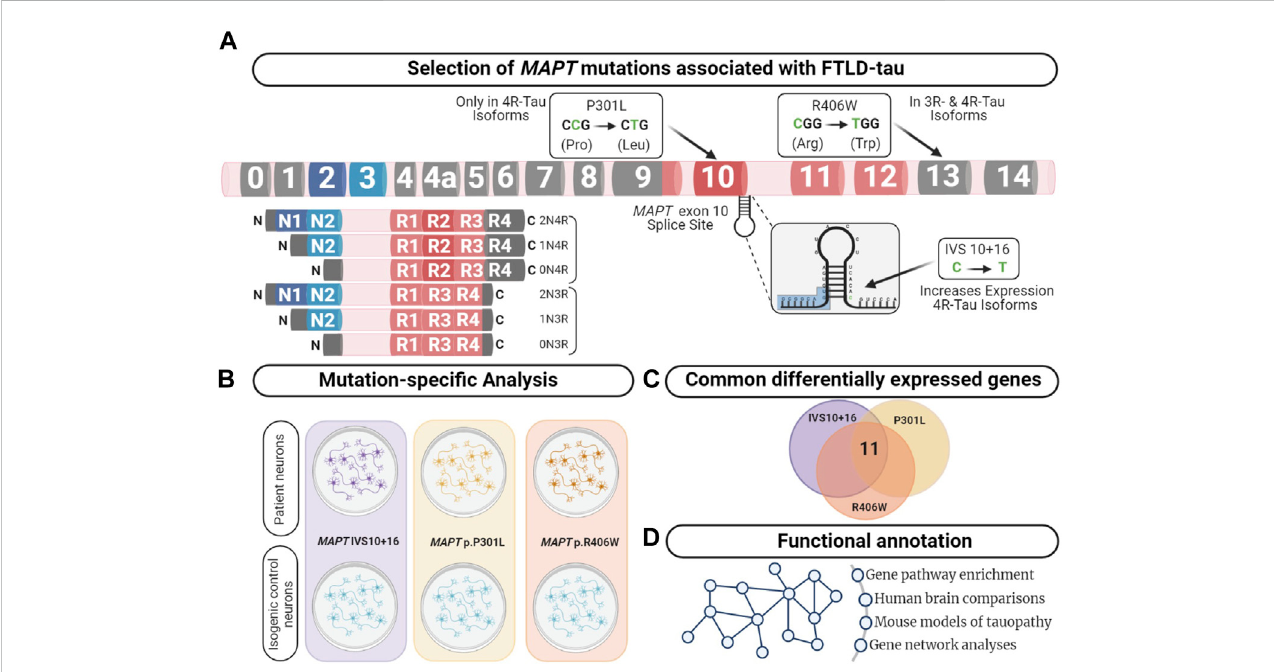
FIGURE 1 Integrativeanalysis toidentifydysregulatedpathwaysinFTLD-Tau. (A) MAPT geneannotatedwiththelocationofthemutations usedinthisstudy.Lower left panel displays the six major isoforms expressed in the central nervous system. (B) Comparison of human iPSC-neurons carrying the MAPT mutation speci fi candisogeniccontrolsservedasadiscoverycohorttoidentifygenesdysregulatedacrossthethreemutations. (C) Overlapanalysisbetweenallmutants compared with control. After multiple test corrections (BY-FDR ≤ 0.05), we identi fi ed 11 commonly differentially expressed genes. (D) Functional annotation was performed using the commonly differentially expressed